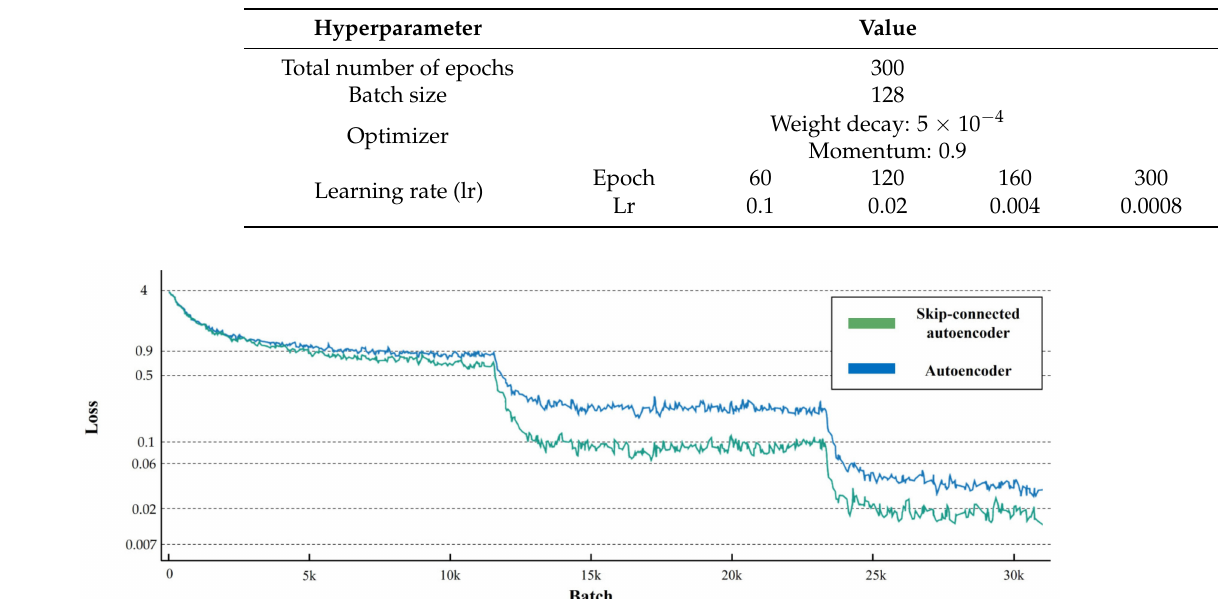
Figure 6. Training losses of the two models. The green line graph is the training loss of the skip-connected convolutional autoencoder, whereas the blue one indicates that of the convolutional autoencoder. Both models show decreased training loss according to the learning rate.